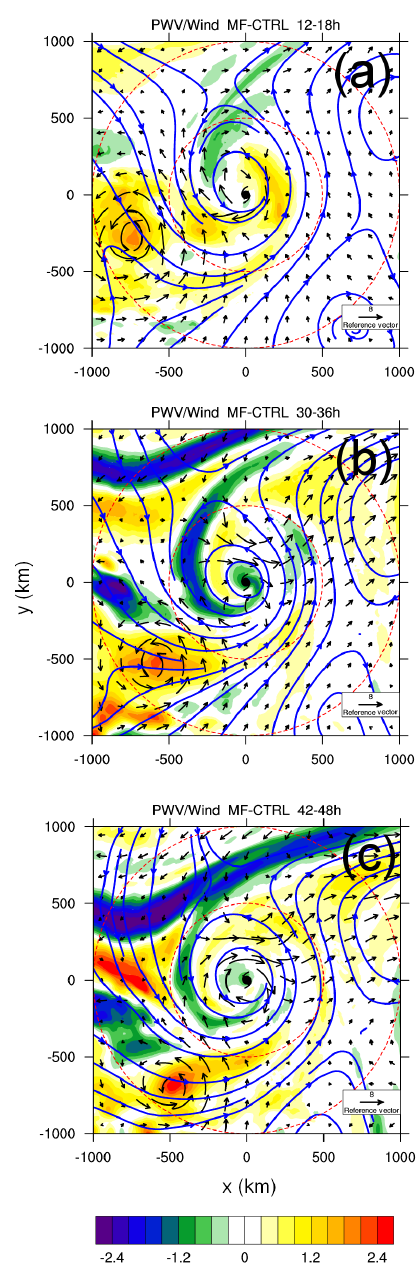
Figure 5. Differences of mean wind vector (ms − 1 ) below 5km and column-integrated PWV (cm) (shading) between the MF and CTRL simulations in the storm-following coordinate: (a) 12–18h; (b) 30– 36h; (c) 42–48h. The blue streamline is the translated streamline at the co-moving coordinate for the CTRL experiment at the cor- responding time. The hurricane symbol shows the TC center. The dashed red circles represent the radius of 500km and 1000km. All the data are taken from the outer model domain. Mean wind vectors and column-integrated PWV for CTRL and MF at each time are shown in Fig. S1 in the